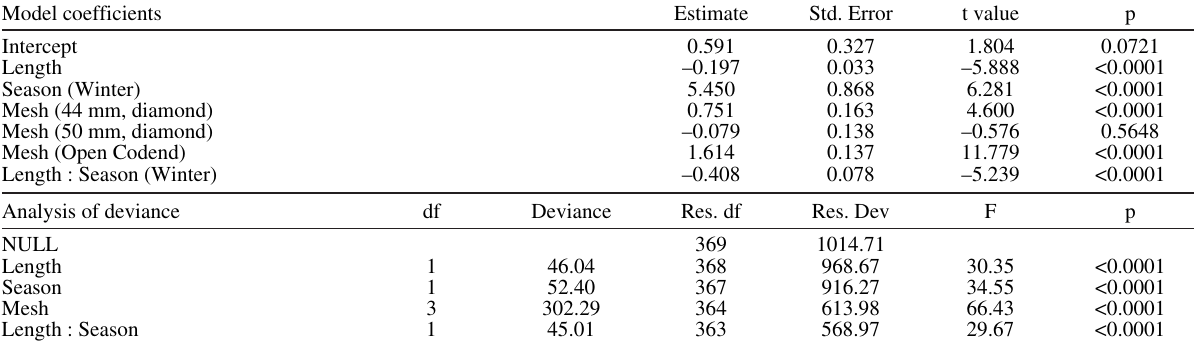
Table 6. – Red mullet. Percentage mortality of fish in 2011 and 2012, in winter and summer, for each treatment (Control, 40-mm square mesh, 44- and 50-mm diamond mesh), with respect to three different length classes (10, 13 and 16 cm TL). Length (cm)